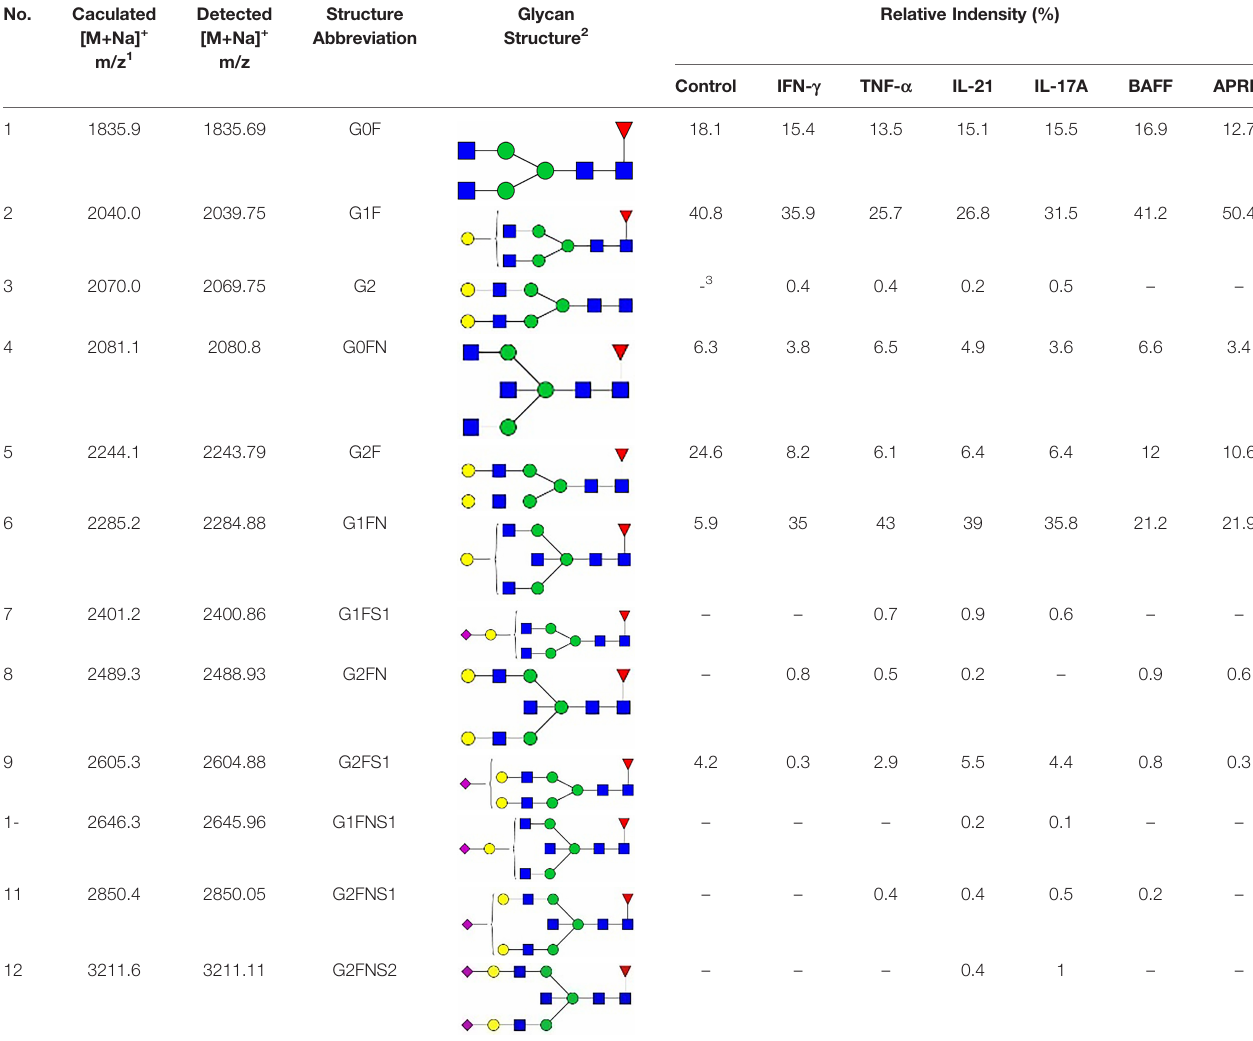
1 Permethylated mass value; 2 Glycan structural features: blue squares, N-acetylglucosamine (N); red triangles, fucose (F); green circles, mannose (M); yellow circles, galactose (G); purple rhombus, sialic acid (S). 3 The undetected N-glycan signals were represented as “ - ” Table 2 . Experiments involving stimulation with each cytokine and control conditions were performed with at least three batches from different donors in three replicates.